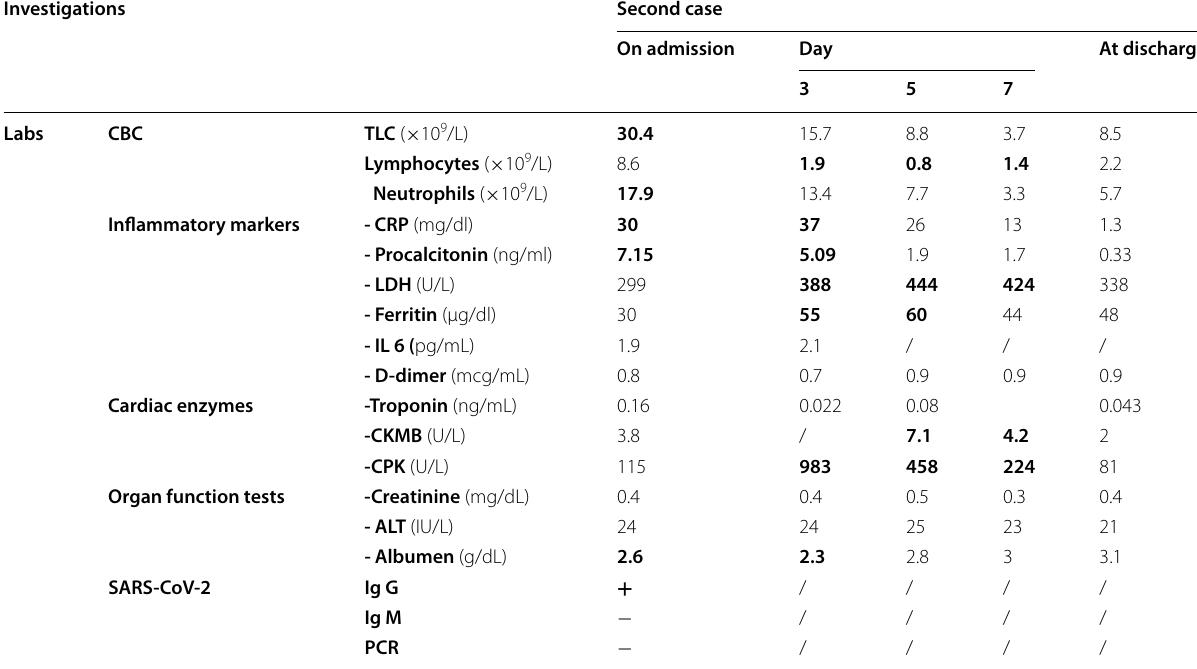
NB: Bold means significant values in diagnosis (see text). Daily laboratory evaluation was performed. Only data of significant changes was mentioned